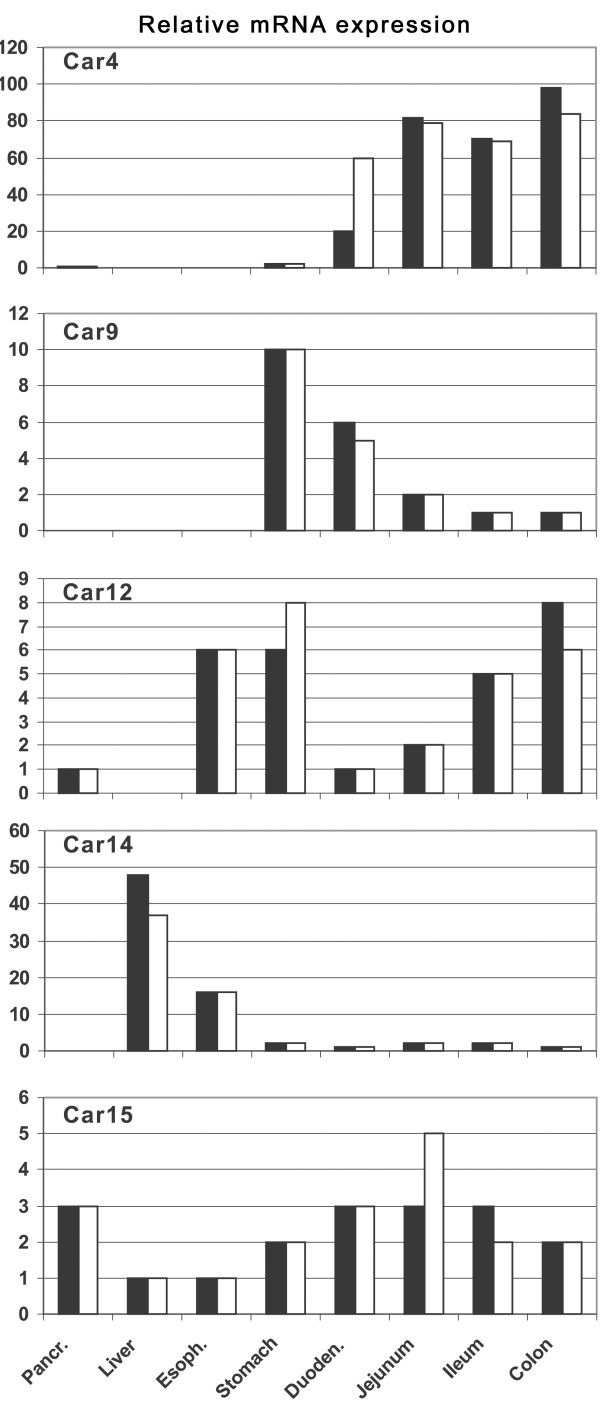
Expression of transcripts for membrane-associated CAs. Solid and open bars represent results obtained from male and female mice, respectively.